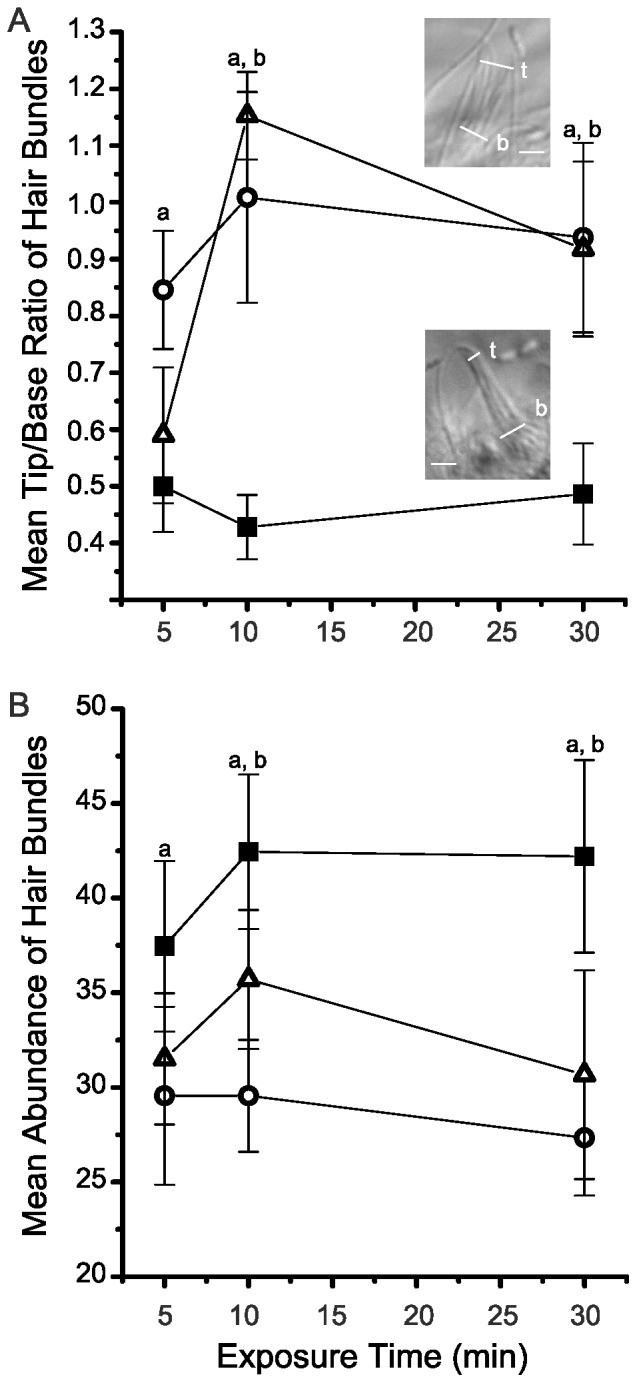
Effects of the CDH23 peptide on morphology and abundance of hair bundles.Hair bundles were evaluated in untreated, healthy controls (closed squares), in animals exposed to 0.1 nM CDH23 peptide (open triangles) or to 10 nM CDH23peptide (open circles). (A) Morphology was assayed by the tip/base ratio. The mean tip/base ratio (±SEM, n = 5–8) is plotted. Insets show representative images of an extremely splayed hair bundle (top) and normal hair bundle (bottom). The diameters of tip (t) and base (b) are indicated. Scale bar  = 2 µm. (B) The mean abundance of hair bundles; ±SEM, n = 3) along the tentacle epithelium is plotted. aSignificant difference between data for the 10 nM CDH23 peptide treated specimens and untreated controls and bSignificant difference between data for the 0.1 nM CDH23 peptide treated specimens and untreated controls.